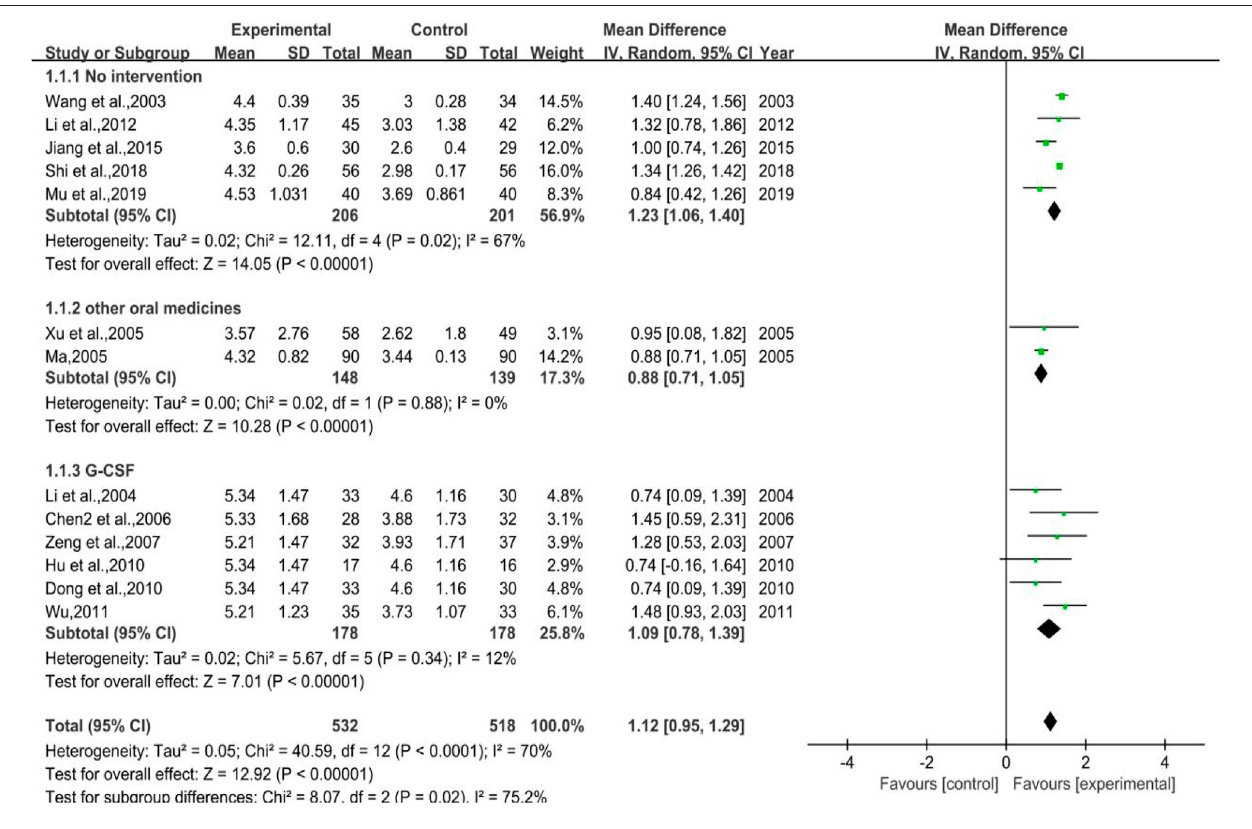
FIGURE 3 | The forest plot of WBC count in preventive medication.